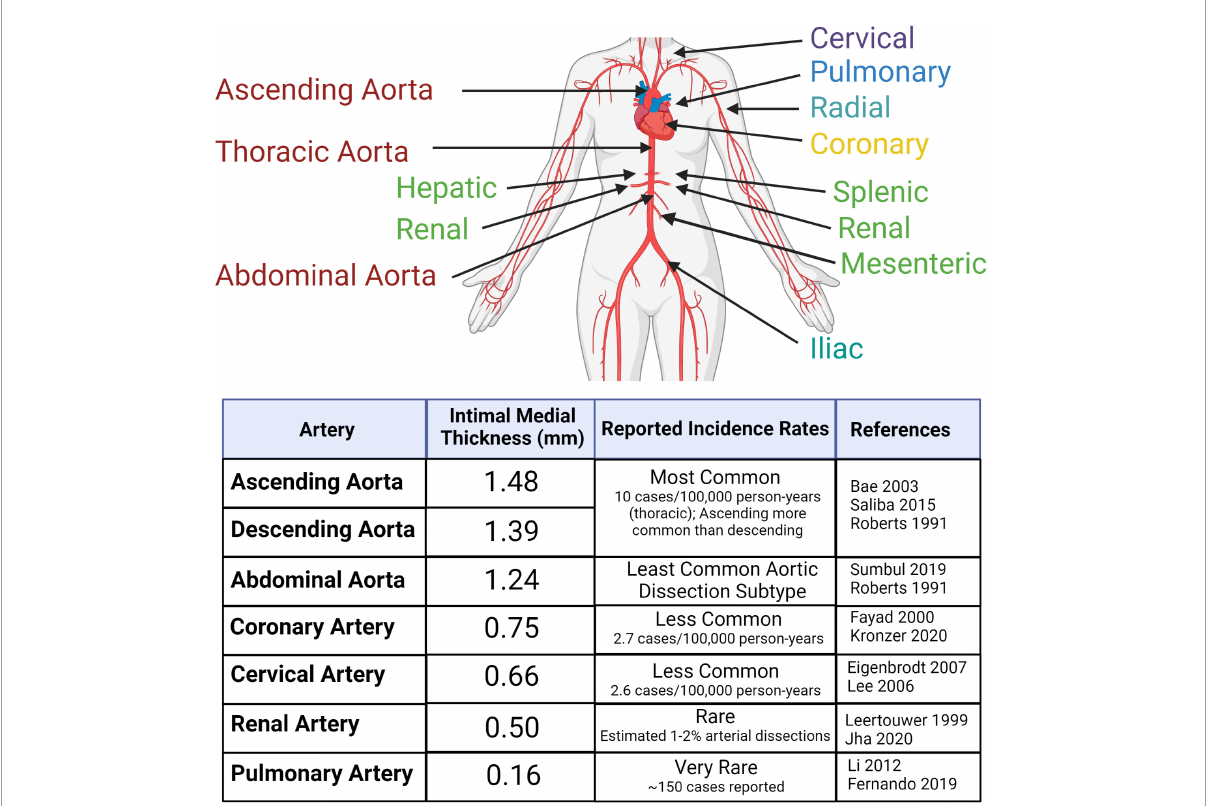
FIGURE1 Arterial dissections are reported in large- and medium-sized arteries throughout the body at varying frequencies within the population. The risk of dissection varies with sex and age. Reported incidences correlate with average intimal medial thickness. Created with